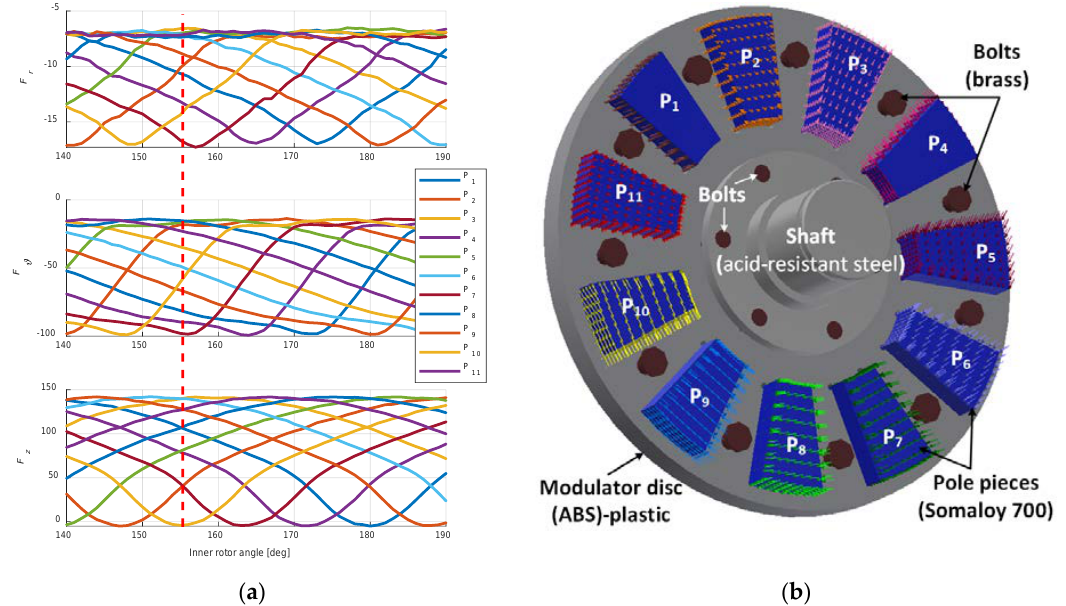
Figure 13. ( a ) Forces components ( F r , F ϑ , F z ,) of MG 2 for all modulator cores (P 1 –P 11 ) used in the mechanical analysis, ( b ) part of modulator disc with visualization of forces applied to each of SMC cores.